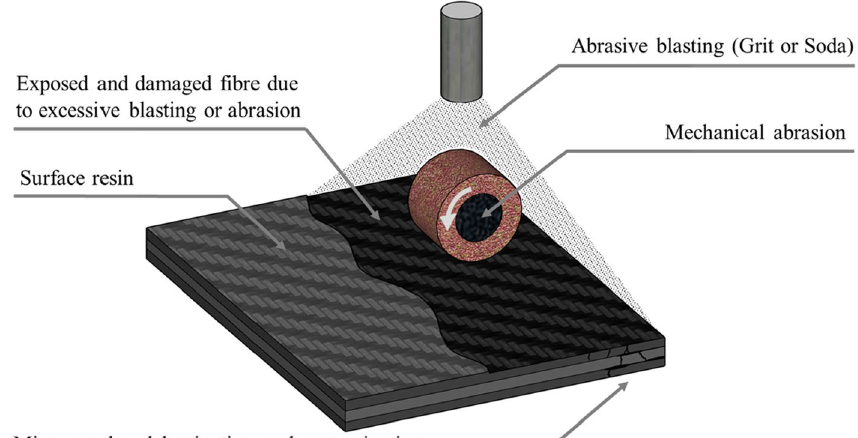
Fig. 11 Illustration of possible composite laminate damage because of excessive surface